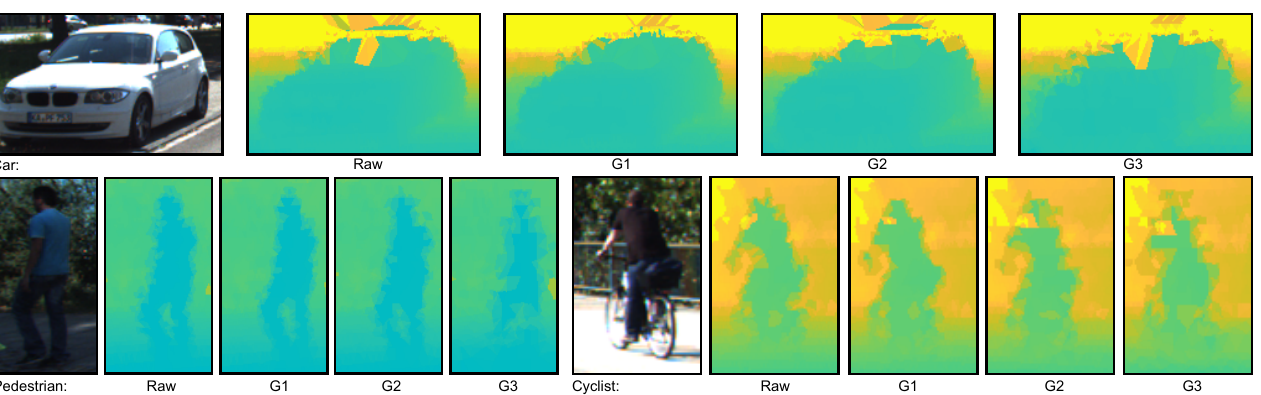
Figure 4. An example of the object classes that were considered from KITTI, with the depth images generated using the bilateral filtering method from point clouds compressed at different degrees. For each object class, from left to right: RGB image, depth images computed from data at G1, G2 and G3 compression degrees.